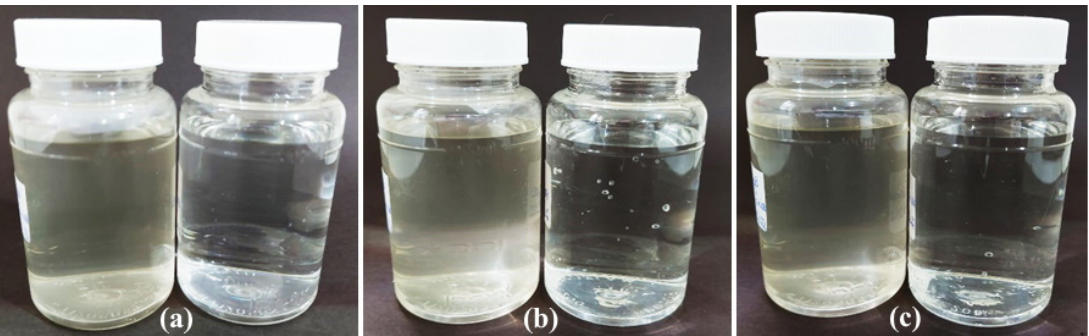
Figure 9. Pictures of the wastewater before and after disinfection tests using: ( a ) pure ZnO, ( b ) Ag/ZnO (I), and ( c ) Ag/ZnO (II).